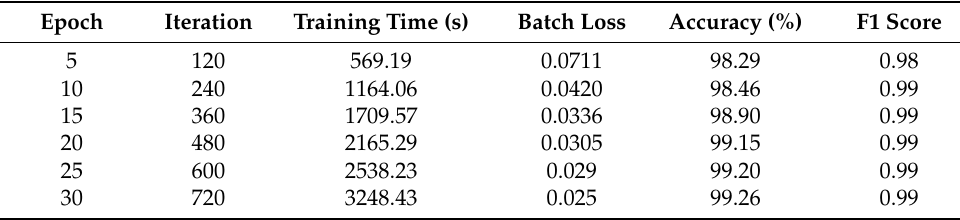
Table 2. Training and validation of the enhanced MobileNetV2 model on Adam.